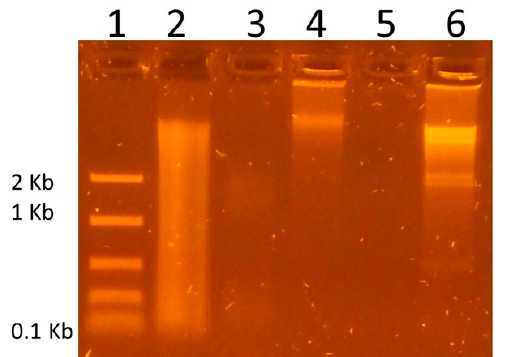
Figure 1. Agarose gel electrophoresis: 1 Easy Ladder; 2 sample P1; 3 external sample; 4 high molecular weight human DNA; 5 external sample; 6 lambda/Hind III molecular weight marker. Numbers on the left indicate reference Kilobases (Kb). Samples 3 and 5 are not included in this study. The results of the quanti fi cation of the Baron’s mother samples are shown in Table 1. Three out of four samples revealed detectable levels by qPCR for the short autosomal tar- gets. Table 1. List of the samples in this study. D.P.R.: Domenica Privato Revoltella; Year: year of the DNA extraction; S.A.T.: concentration of the sample as assessed by the short autosomal target in the qPCR assay; L.A.T.: concentration of the sample as assessed by long autosomal target in the qPCR assay; D.I: ratio between S.A.T. and L.A.T. The last two columns show the number of mitochondrial (mt) DNA molecules, as assessed by the 113 bp and 287 bp long targets, respectively. LOD: limit of de- tection; n-c: not calculable; n.p.: not performed.